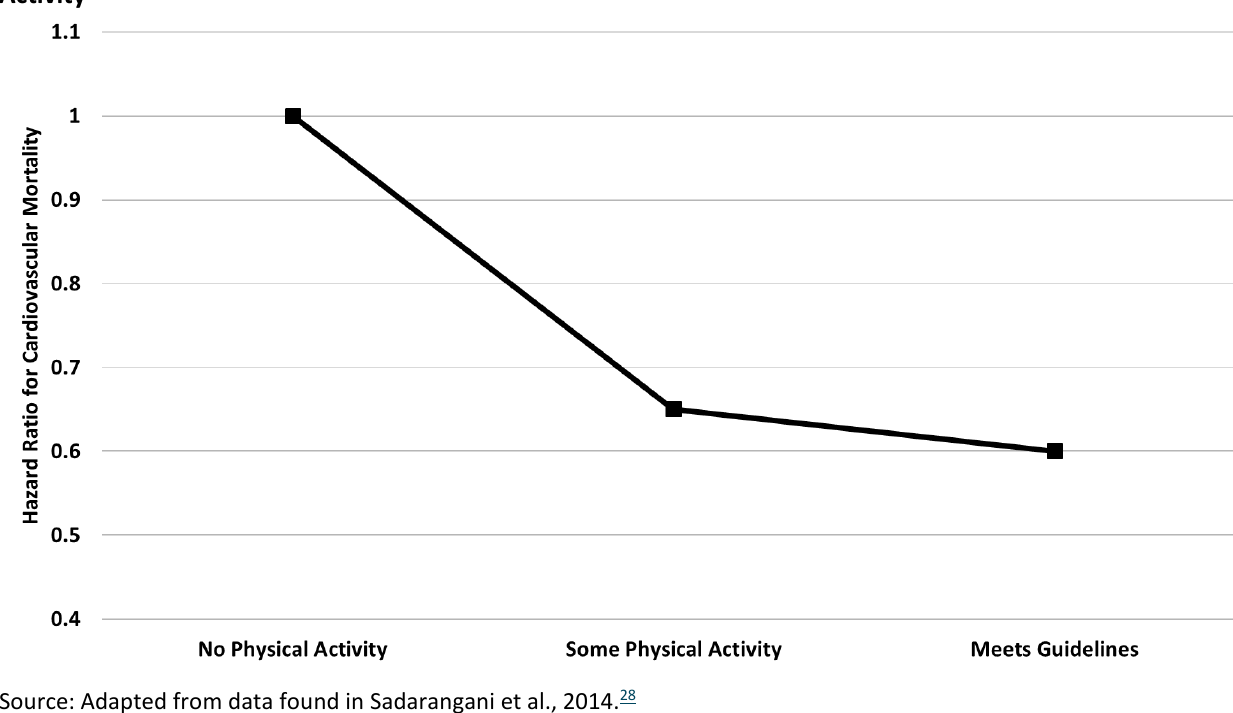
Figure C-2. Risk of Cardiovascular Mortality Among People with Type 2 Diabetes by Dose of Physical